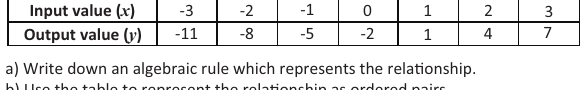
FIGURE 4: Comparison of each category used in the coding process for procedural and conceptual knowledge.